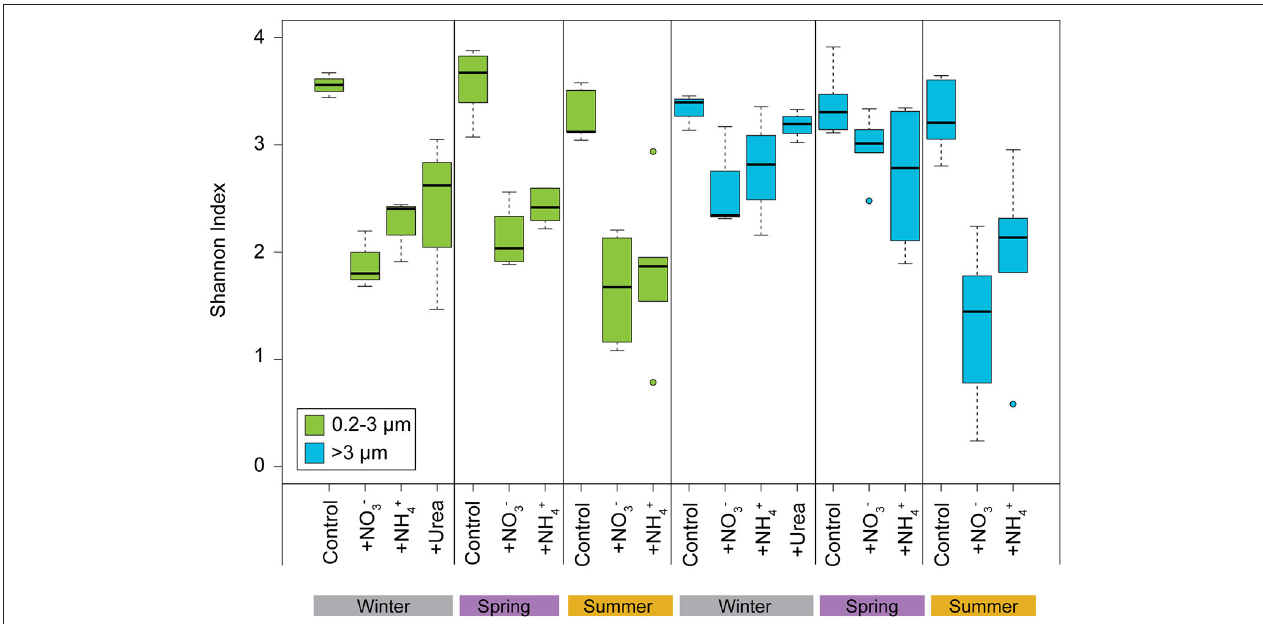
FIGURE 6 | Alpha diversity (Shannon index) of the pico- and > 3 µ m phytoplankton V9 18S rDNA OTUs at final time points for Control, + NO − 3 , and + NH + 4 treatments binned by winter, spring, and summer. Boxplot parameters are the same as described for Figure 1